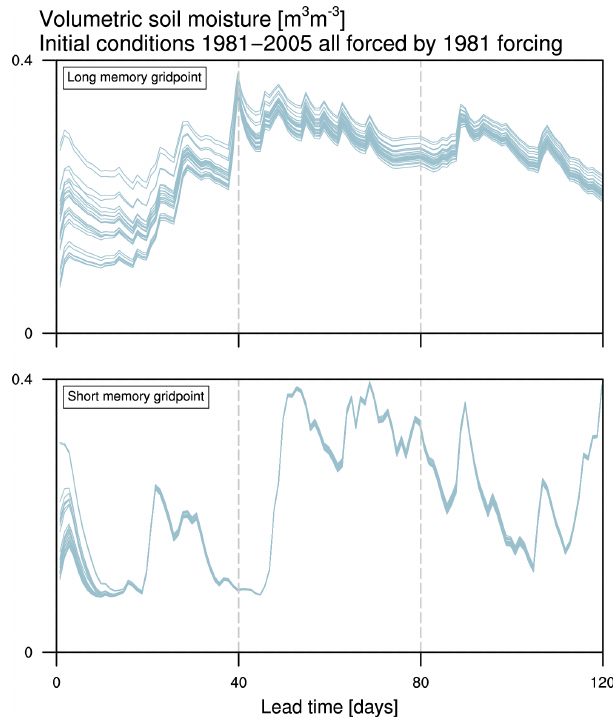
Figure 1. An example of the evolution of top level soil moisture from an ensemble of 25 initial states, each forced with the same year’s forcing (in this case, 1981). Data from each plot are taken from different grid points, chosen to demonstrate a situation of long and short memory. Note that in the latter case memory of initial conditions is lost by around day 20, whilst the former case retains knowledge of the initial state for several